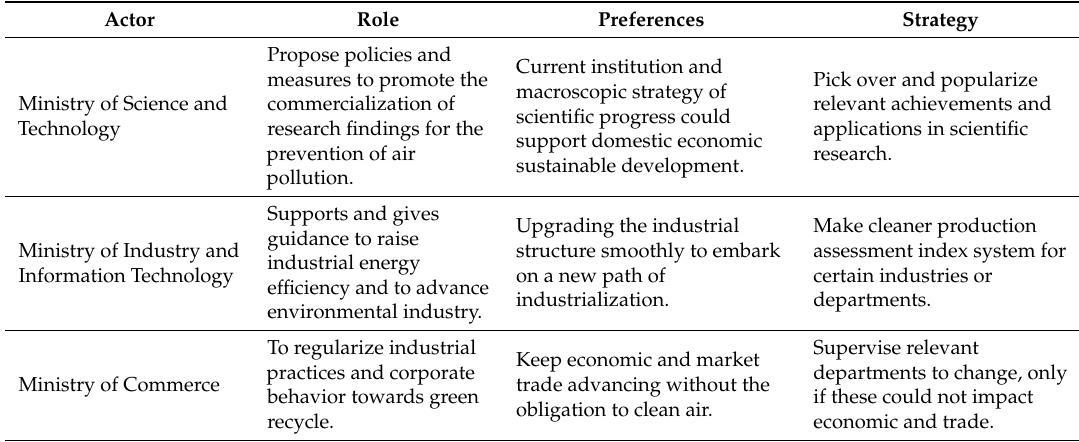
Table 5. Other involved policy actors in central